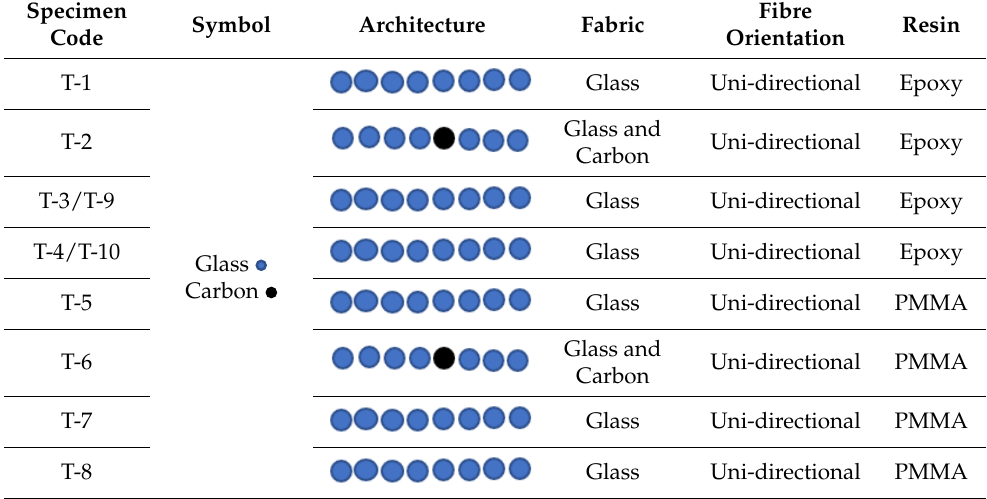
Table 1. Composite architecture.